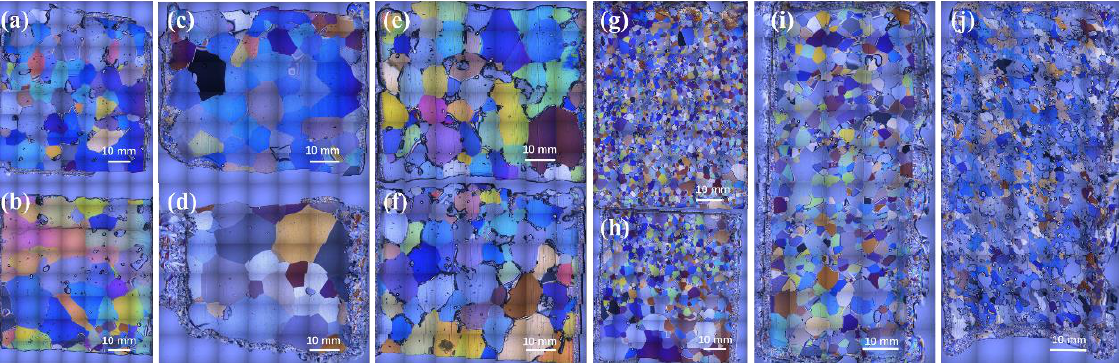
Figure 2. Microstructure maps of thin sections. ( a ) IC1-1; ( b ) IC1-2; ( c ) IC1-9; ( d ) IC1-10; ( e ) IC3-1; ( f ) IC3-2; ( g ) IC3-12; ( h ) IC3-13; ( i ) IW5; ( j ) OIW5.